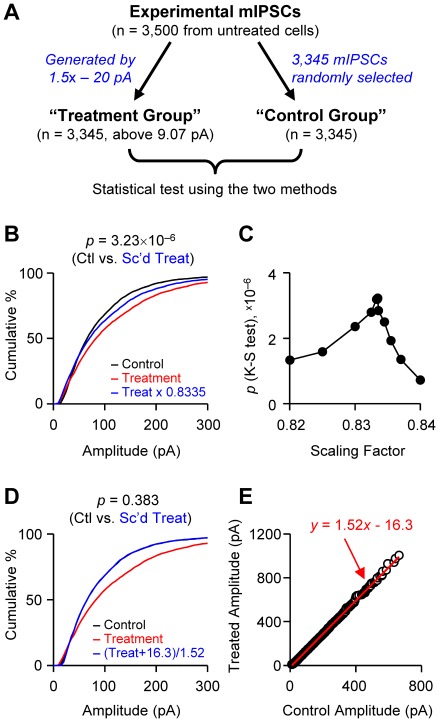
Tests for multiplicative scaling using two different methods and artificially generated data sets.
A. Data generation scheme. mIPSC amplitudes (n = 3,500) recorded experimentally from untreated cells were arithmetically transformed: i.e., they were multiplied by 1.5 and subtracted by 20 pA. After the transformation, 3,345 values were above the detection threshold and this set was called the “treatment group”. Randomly selected values from the experimental group made up the “control group” (n = 3,345). B–C. As in Fig. 3, the treatment group was scaled down and compared with the control group using K-S tests. When the scaling factor was 0.8335, the distribution of the scaled treated group most completely overlapped that of the control group. The p value (K-S test) shows significant difference between the control and scaled treatment groups. D–E. In the conventional test, the amplitudes of control and treatment groups were rank-ordered and plotted against each other. The treatment group was scaled back using the linear regression equation. The distributions of control and scaled treatment groups were not significantly different from each other (K-S test).